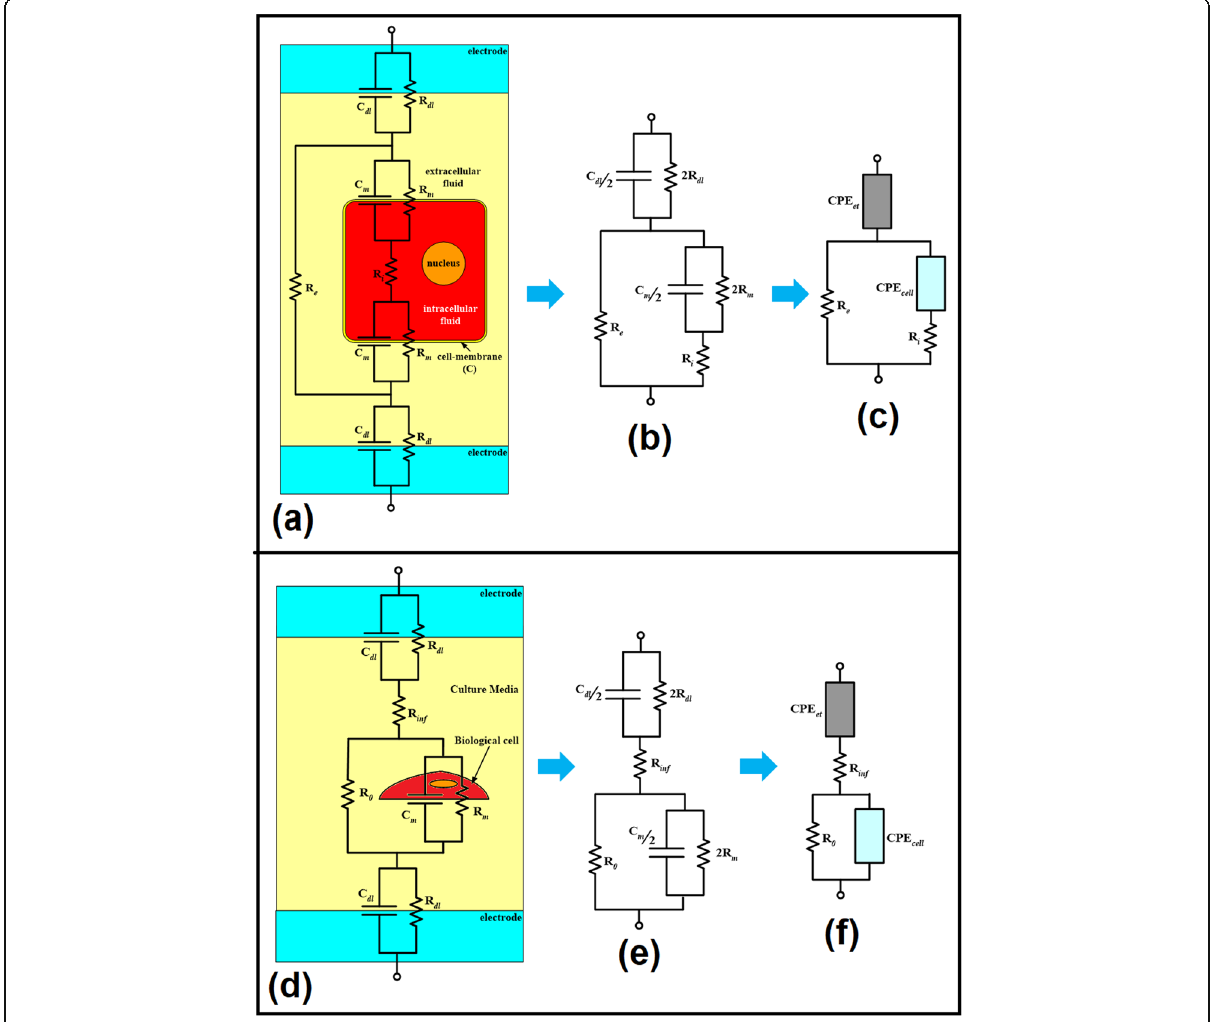
Fig. 5 Equivalent circuit model of biological cells. a Fricke-Morse model. c Modified Fricke-Morse model. d Cole-Cole model. f Modified Cole-Cole model. While b and e are simplification